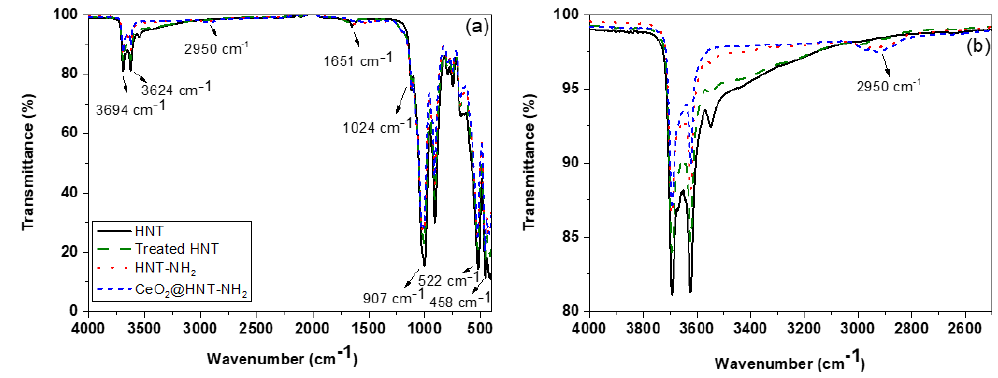
Figure 2. Fourier-transform infrared (FT-IR) spectra of HNTs, acid-treated HNTs, HNT - NH 2 -and CeO 2 @HNT-NH 2 ( a ). In ( b ) is represented the enlarged 4000–2500 cm − 1 region.